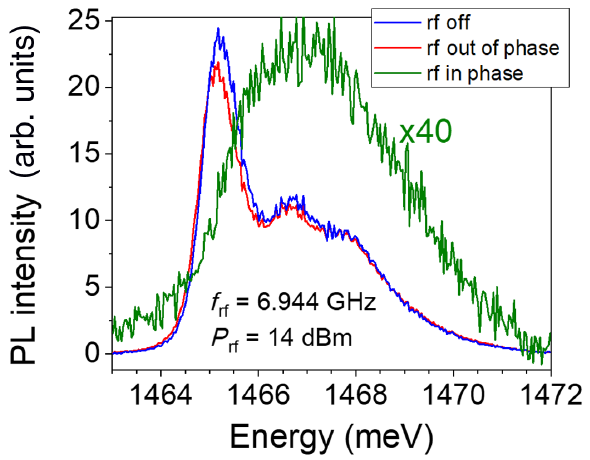
11. (a) Comparison of the PL under three different rf conditions: (i) rf off, (ii) rf out of phase, and (iii) rf in phase. The in phase and out of phase are measured at the same resonant rf frequency 6.944 GHz and the same applied rf power 14